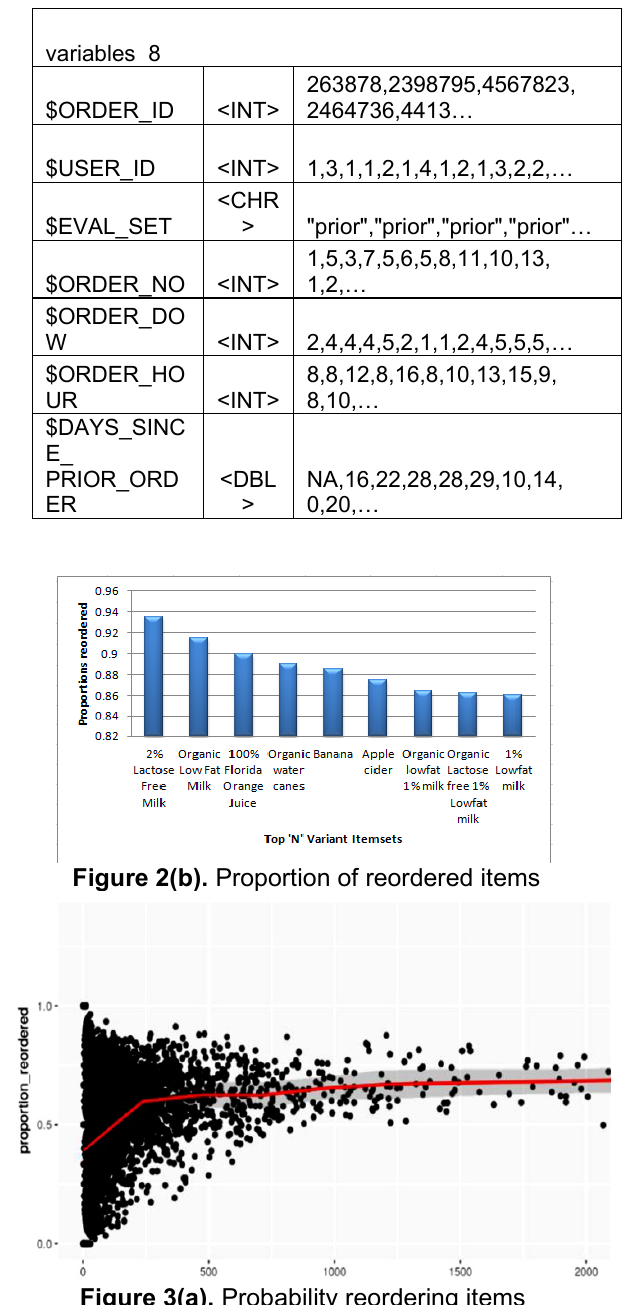
Table 2. Sample transactions in the dataset